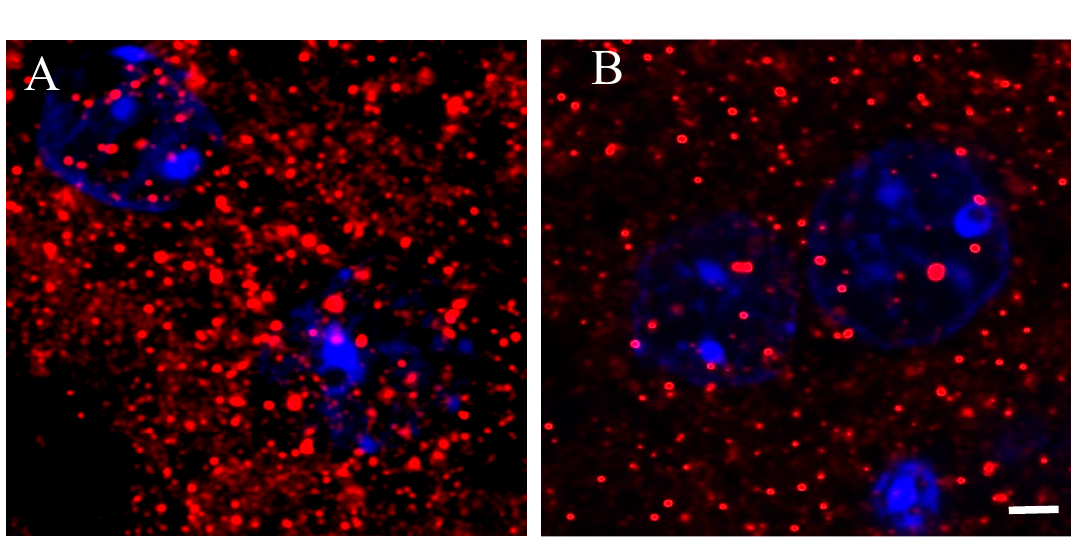
Figure 4. Representative immune-fluorescence microphotographs of high magnification (63 × plus zoom factor 1 × –1.5 × –2 × ) confocal laser scanning microscopy, double-labeled for D2 receptors and for nuclei in the striatum of control Tor1a +/+ ( A ), and of mutant Tor1a +/ − knock-out ( B ) mice. D2 receptor immune-labeling is visualized in red-Cy3 fluorescence, while nuclei are visualized by DAPI fluorescence in blue. Bar in B = 2 µm.